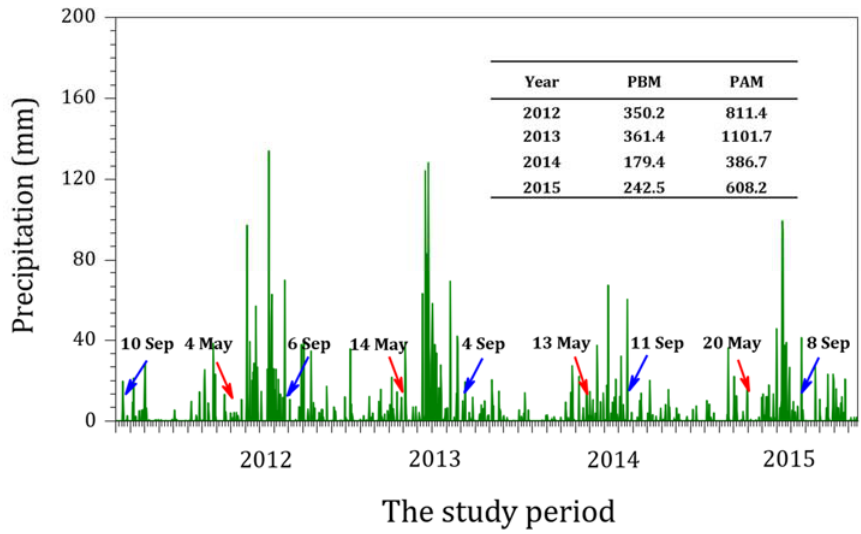
Figure 2. Daily precipitation in the Hantangang River basin between 2012 and 2015, measured by a Korea Weather Center (http://www.kma.go.kr/index.jsp). The arrows are the sampling dates before (red) and after the monsoon (blue), respectively. A small table in the figure showed the total precipitation for the periods of before (PBM) and after monsoon (PAM); In 2012, PBM or the former indicate the sum of daily precipitation from 10 September to 3 May, while PAM or the latter are those from 4 May to 6 September of 2012, respectively.